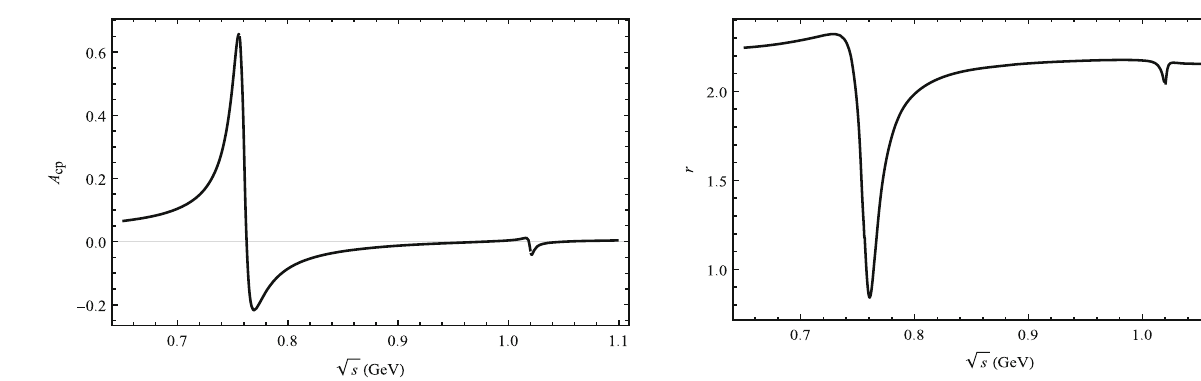
Fig. 4 Plot of r as a function of